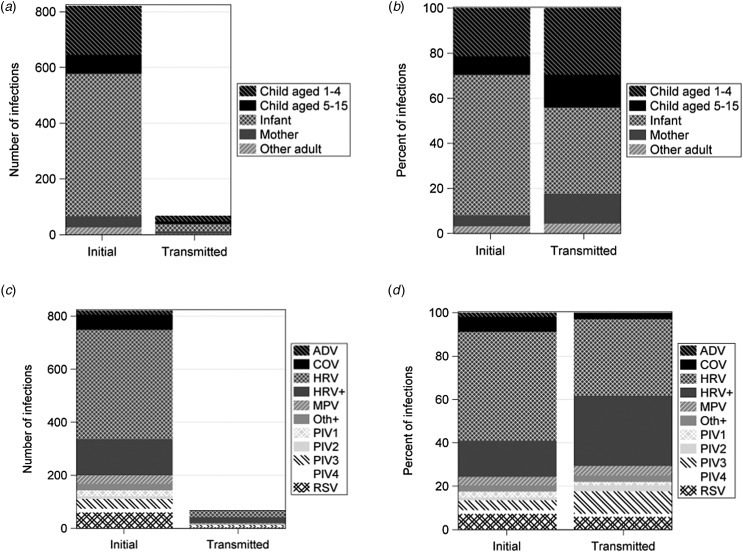
All initial illness episodes vs. initial episodes resulting in any transmission by proportions and counts. (Upper) Illness episodes compared by household member type of index case in counts (a) and proportion of episodes (b). (Lower) Illness episodes compared by virus of index case in counts (a) and proportion of episodes (b). HRV + represents coinfection of HRV and 1 + other virus. Oth + represents coinfection not involving HRV.